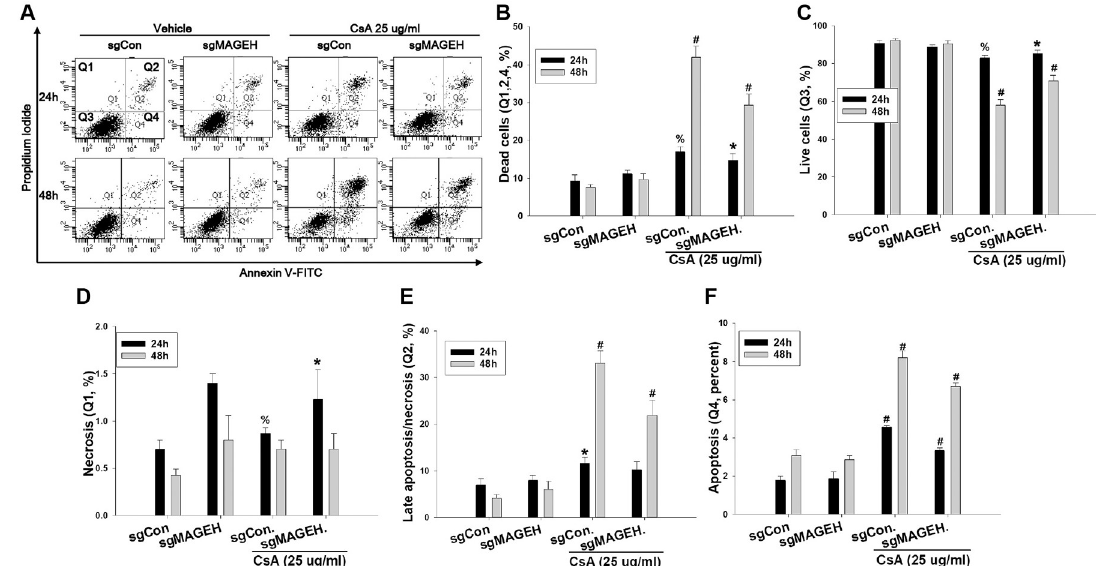
Fig 5. Quantification of apoptosis and necrosis by flow cytometry in CsA-treated HRE cells: Effect of MAGEH1 knockdown. sgMAGEH and sgCon stable HRE cells were incubated with 25 μ g/ml CsA for the indicated time periods. (A) Representative scatter plots of flow cytometry. Quantification of (B) dead cells (Q1+Q2+Q4), (C) viable cells (PI negative and Annexin V negative, Q3), (D) necrotic/non-viable cells (PI positive and Annexin V negative, Q1) (E) late apoptotic/necrotic cells (PI positive and Annexin V positive, Q2), and (F) early apoptotic cells (PI negative and Annexin V positive, Q4). Each bar represents mean ± SD of 3 experiments. One-way ANOVA followed by Bonferroni’s post-hoc comparisons tests was used to compare groups. A p value < 0.05 was considered significant. % p < 0.05 vs. sgMAGEH; � p < 0.05 vs. the corresponding sgCon group; #p < 0.05 vs. all other corresponding groups. sgMAGEH represents single guide RNA constructs to knockdown MAGEH1; sgCon, control single guide RNA constructs targeting no known